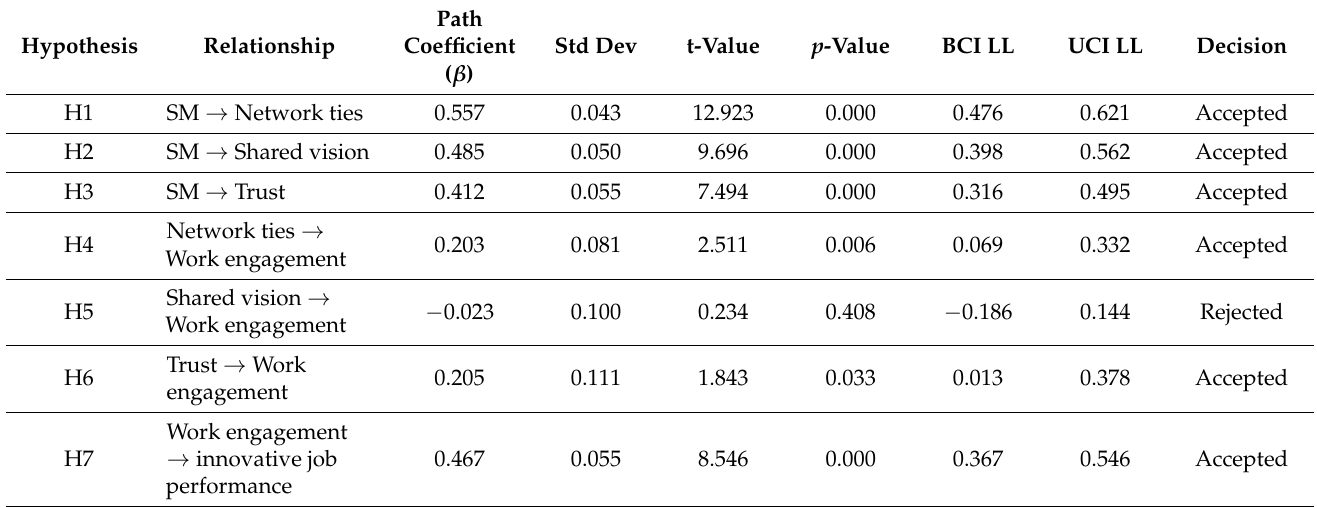
Table 7. Hypothesis Testing.